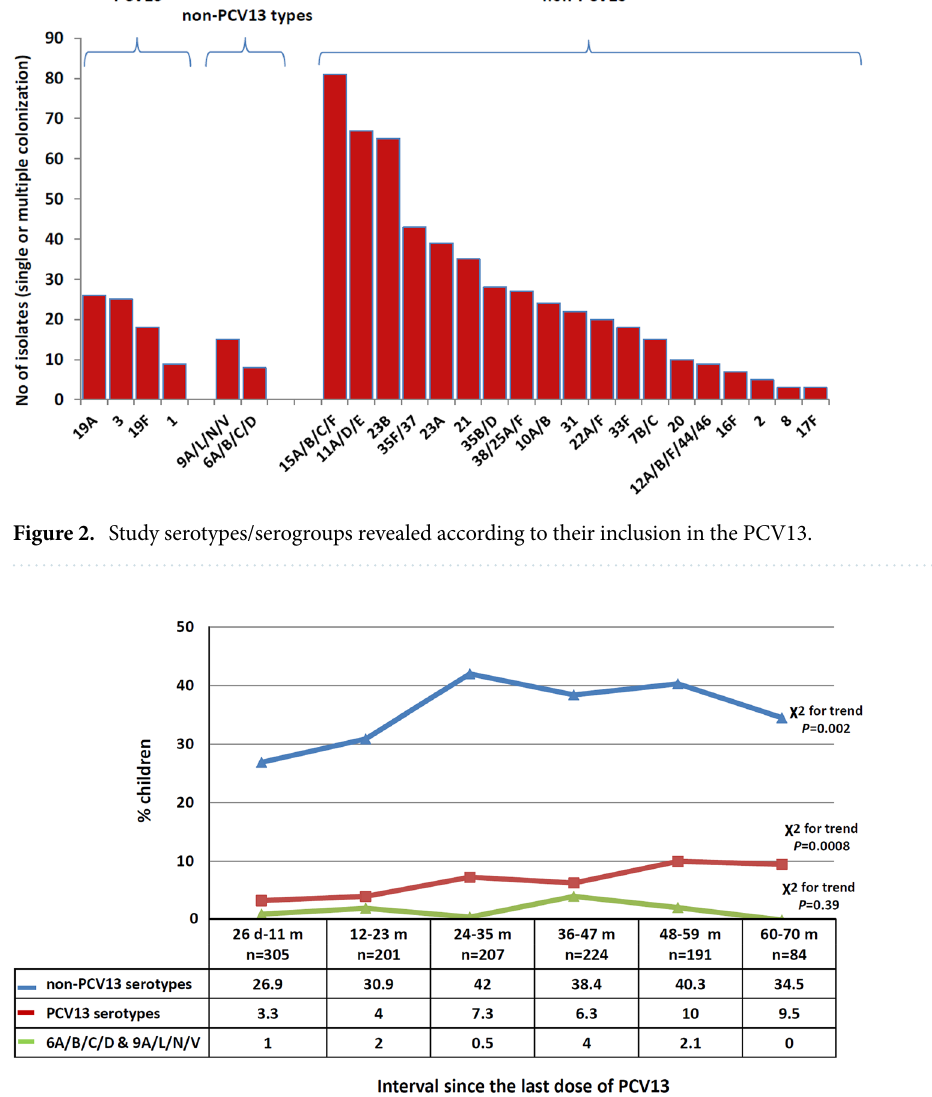
Figure 3. Percentage of colonized children with non-PCV13 serotypes, PCV13 serotypes, and serogroups 6A/B/C/D and 9A/L/N/V according to time elapsed since the 4th (booster) dose. There is significant increase of colonization with non-PCV13 and PCV13 serotypes with increasing time